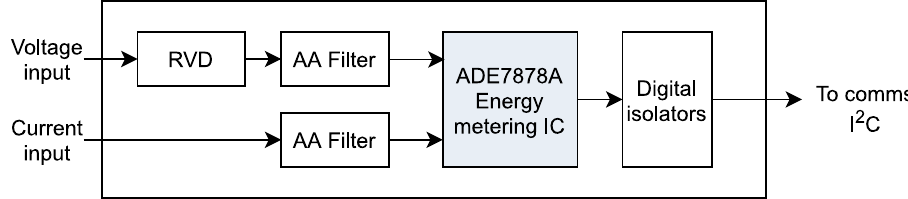
Figure 5. EVAL-ADE7878AEBZ evaluation board diagram.